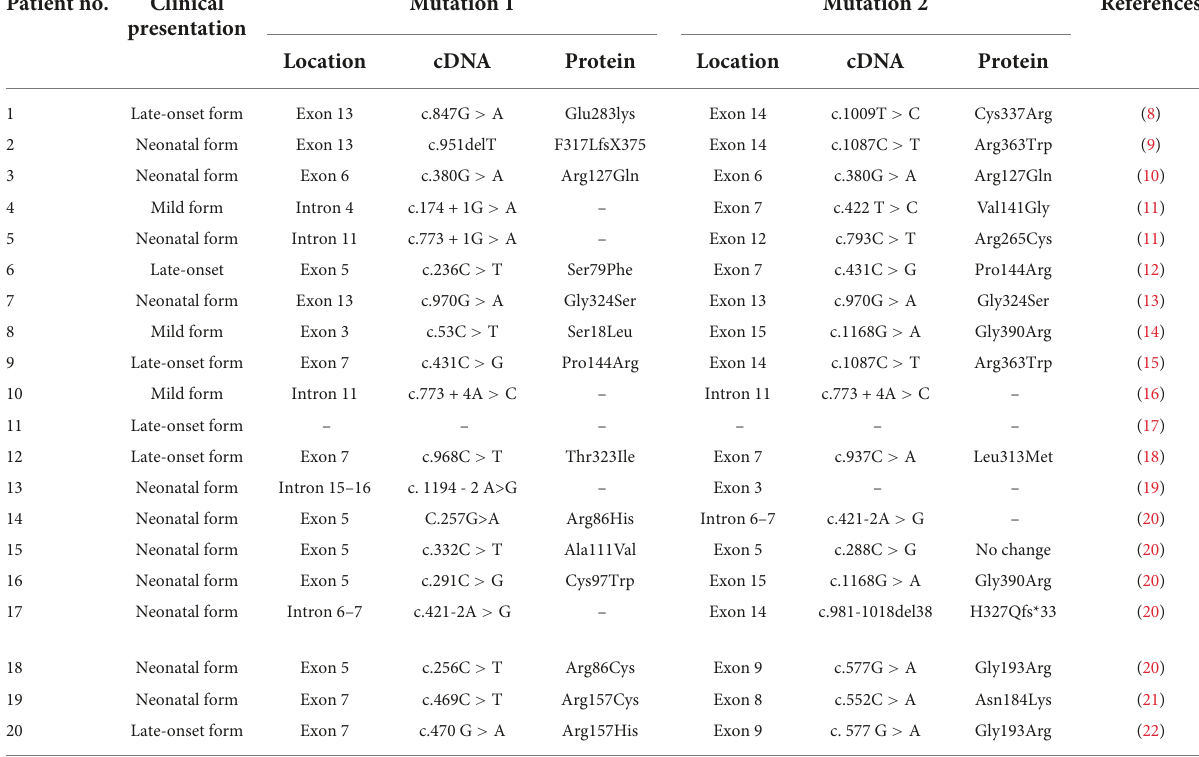
TABLE 6 Genetic investigations of patients described in the literature. Patient